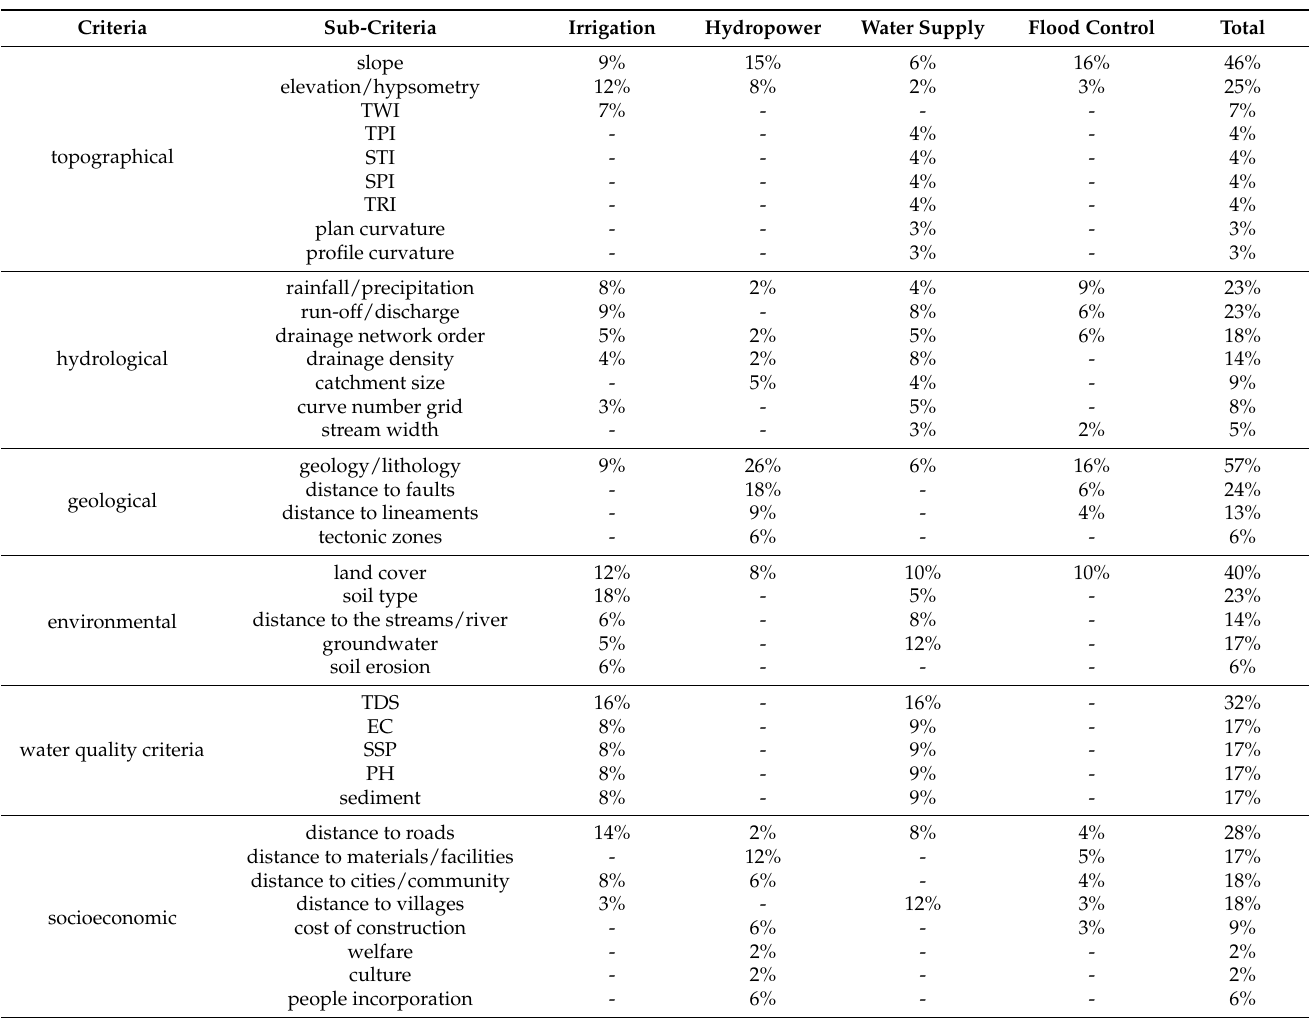
Table 8. Share of criteria in different